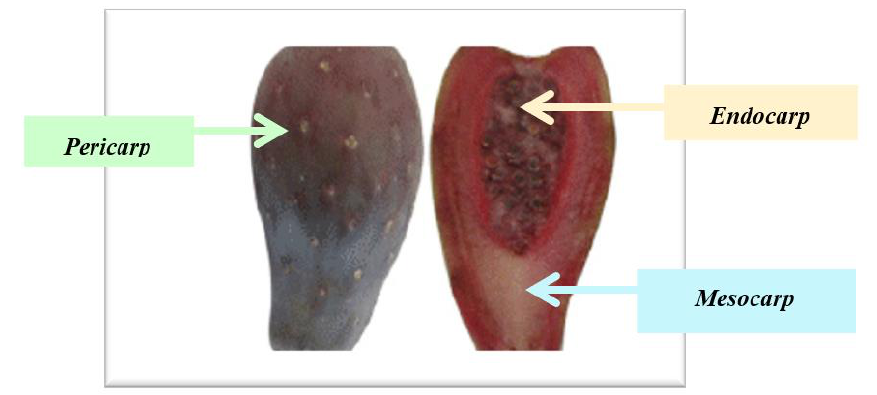
Figure 1. Xoconostle Ulapa ( Opuntia oligacantha C.F. Först) .